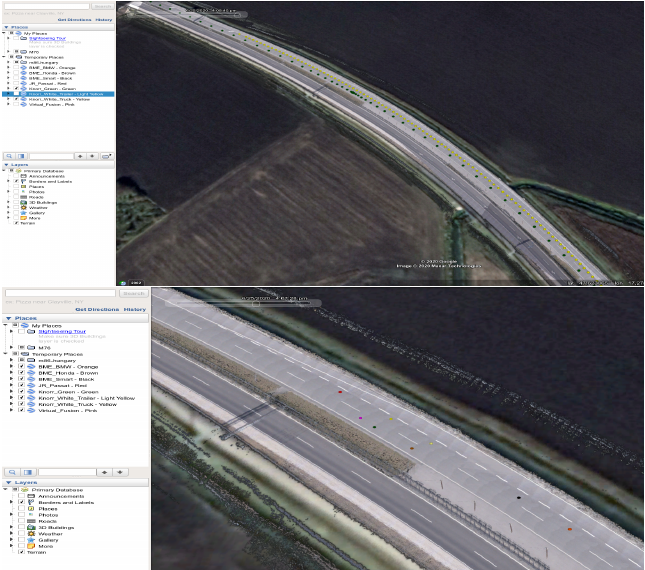
Figure 26. Plotted trajectories for the whole time interval of the test run ( top ) and for a given moment ( down ).